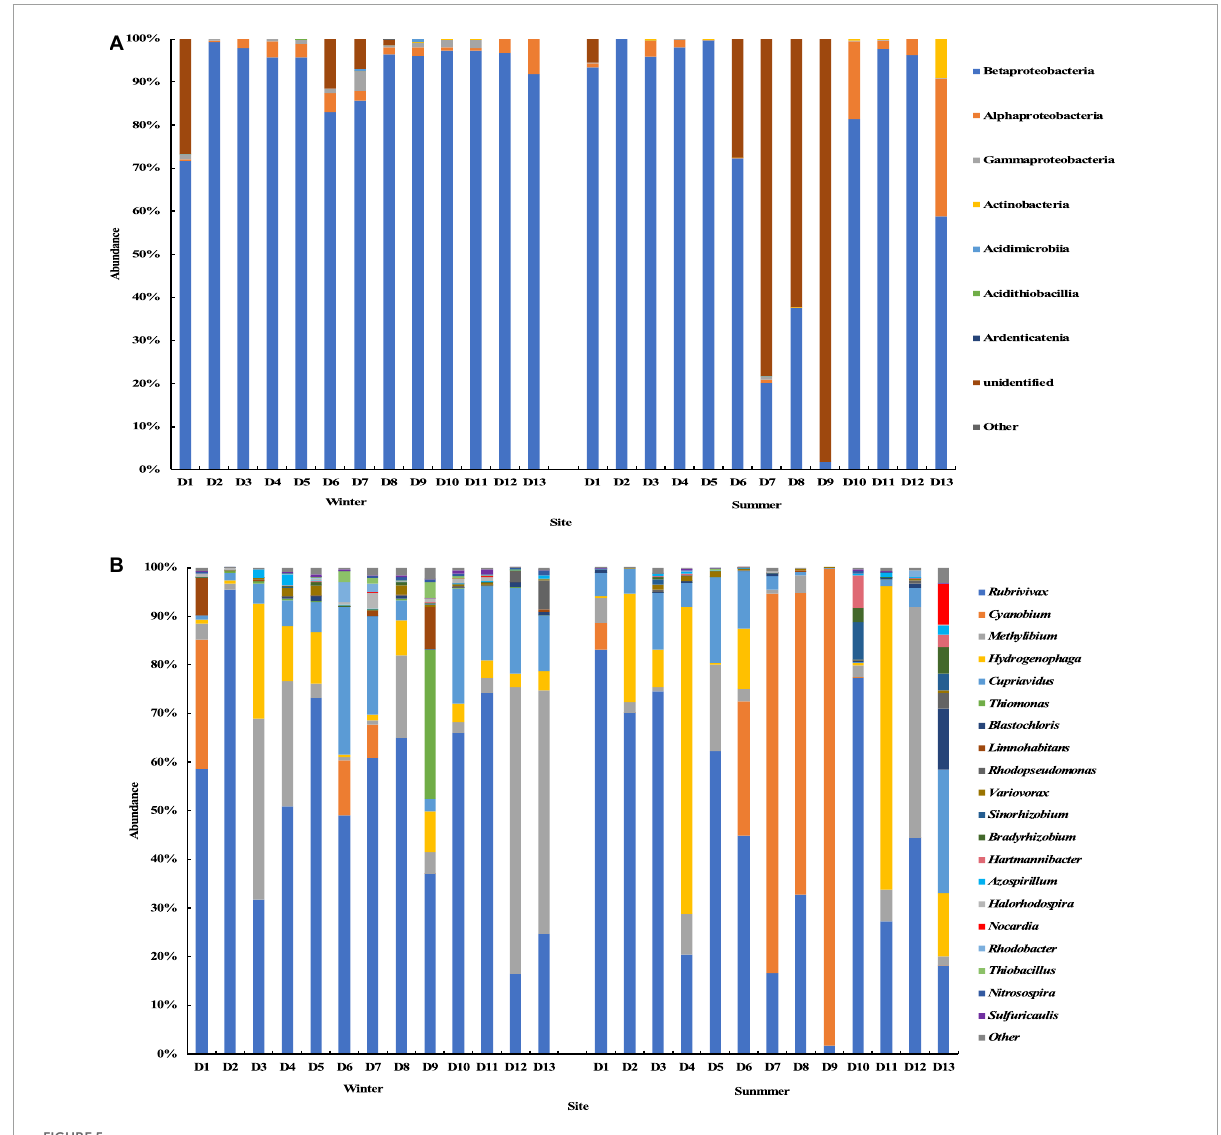
FIGURE5 Relative abundance and composition of the cbbL gene-containing CO 2 -fixing bacterial community at the class level (A) and genus level (B) in the Huixian karst